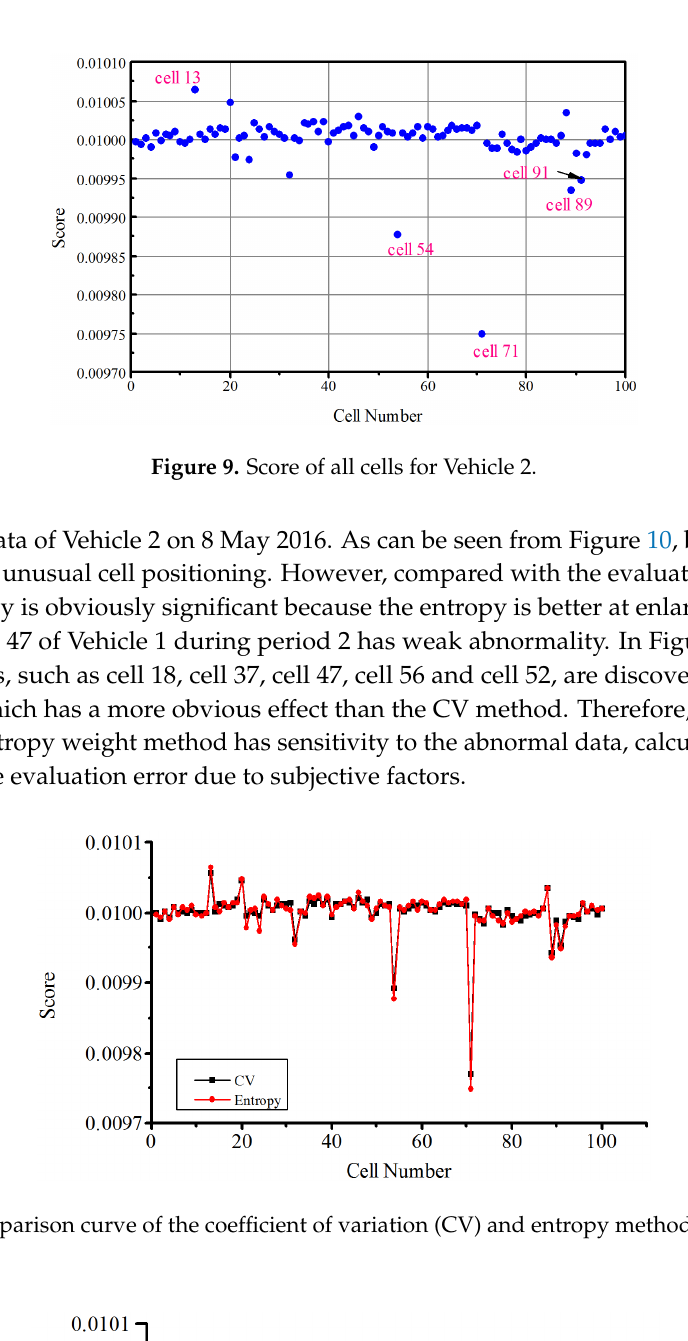
Figure 10. Comparison curve of the coefficient of variation (CV) and entropy method of Vehicle 2 on